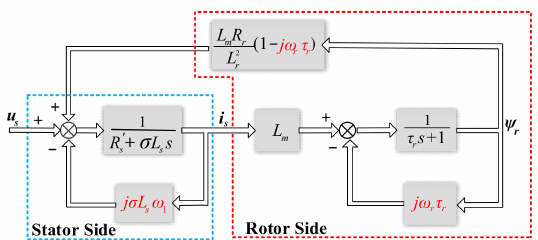
Figure 2. Complex vector signal flow diagram of induction motor in dq coordinate system. The second coupling factor in the feed-back loop is at the stator side. The coupling value increases with the increase in the synchronous angular frequency. That is why the current coupling in the middle and high-speed section of the motor is